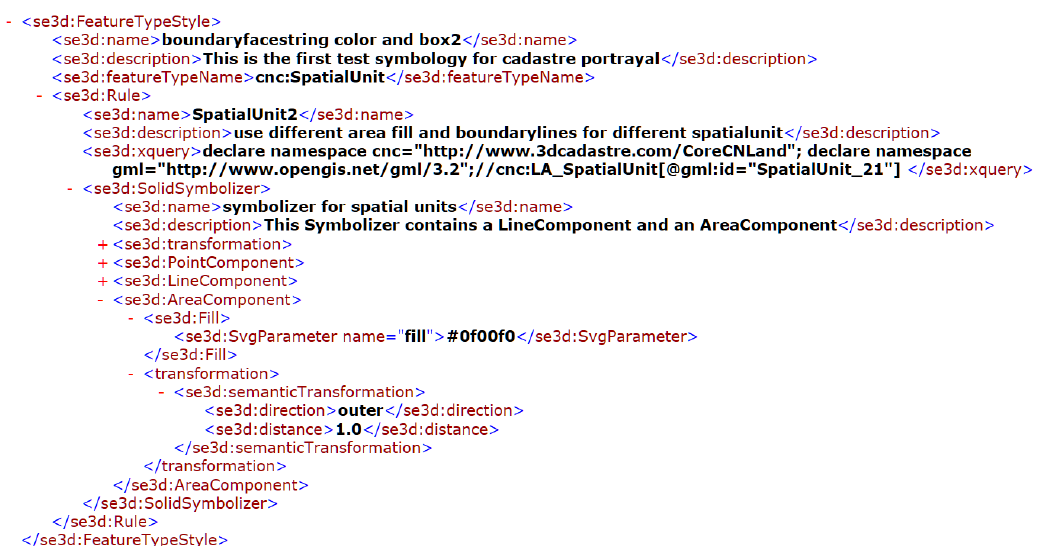
Figure 4. One of the SE-encoded symbolic rules that define the cartographically enriched 3D cadastre scene in Figure 3. In this encoding part, there is one SolidSymbolizer tag with the point, line, and area components. The explosion effect is expressed by the semanticTransformation tag.